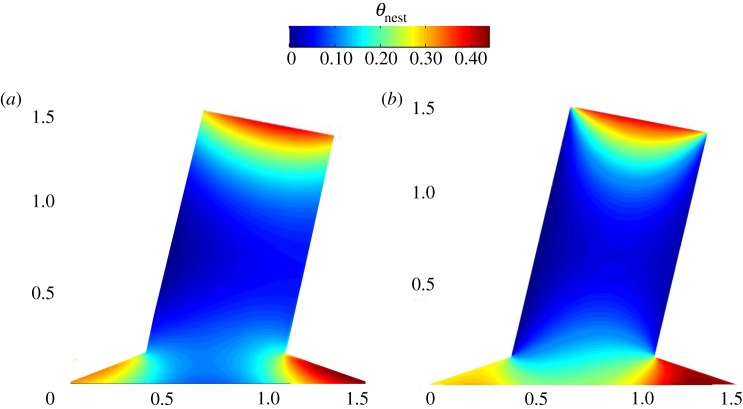
A comparison between the temperature distribution of the 2D model (b) and a cross-section from the centre of a 3D model (a).